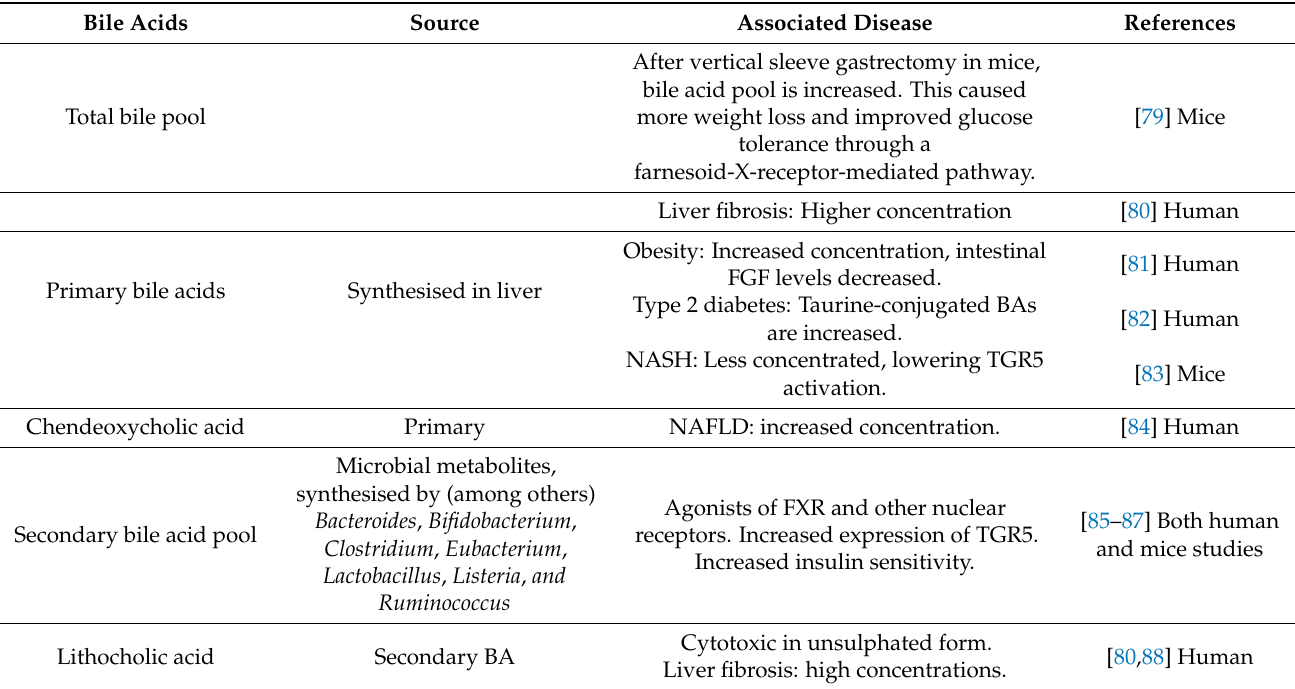
Table 1. In vivo bile acids and associated CMD in the literature. Specific bile acids are only shown if associations with CMD were found in clinical or animal studies. There are some contradictory results due to different physiologies in mice and humans. Only relevant studies are